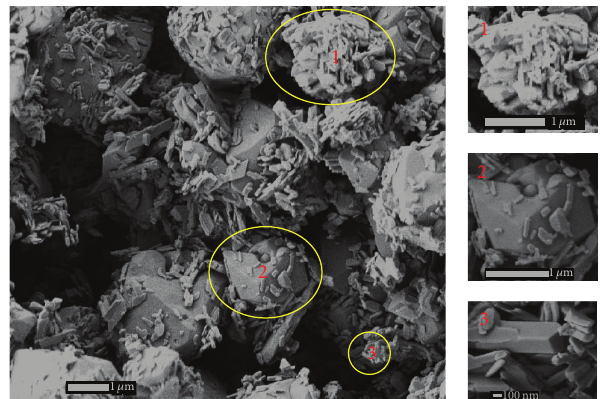
Figure 4: SEM image of BiVO 4 showing various